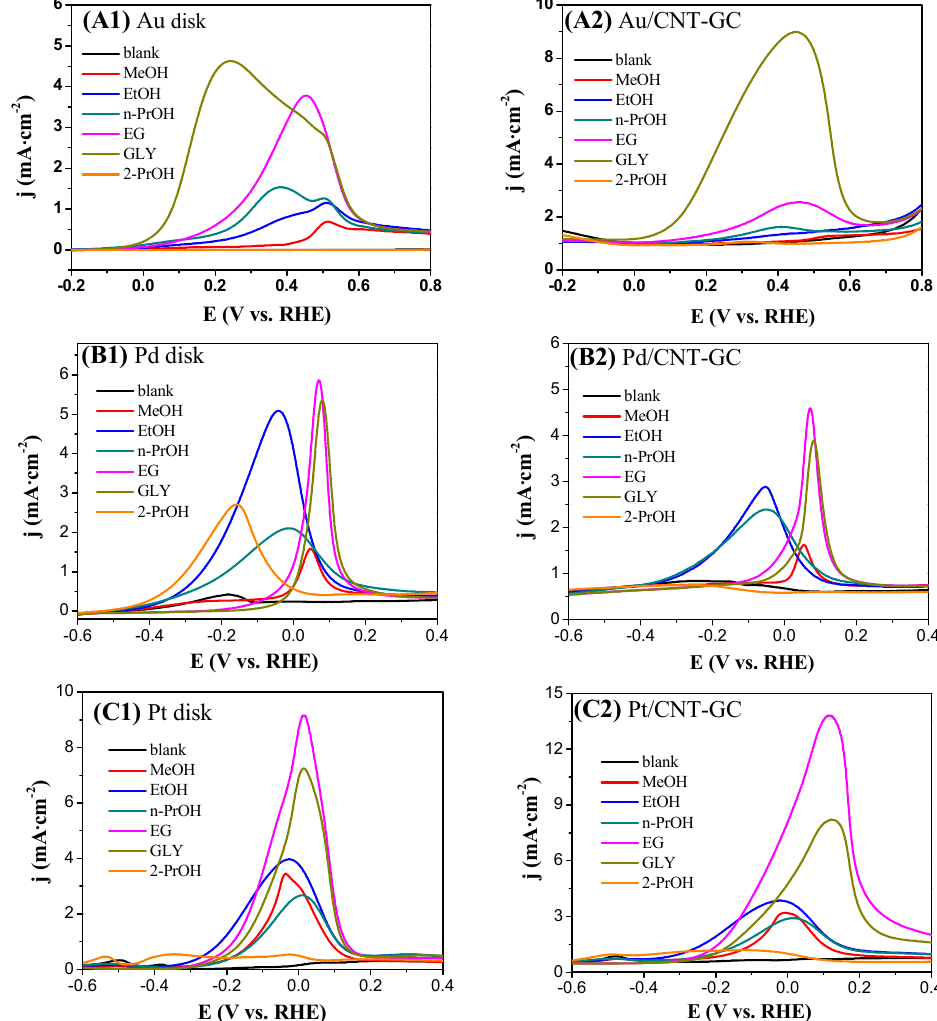
Figure 5. Voltammetry curves (100 mV s − 1 ) of alcohol electro-oxidation over different electrodes in 0.1 M KOH solution.